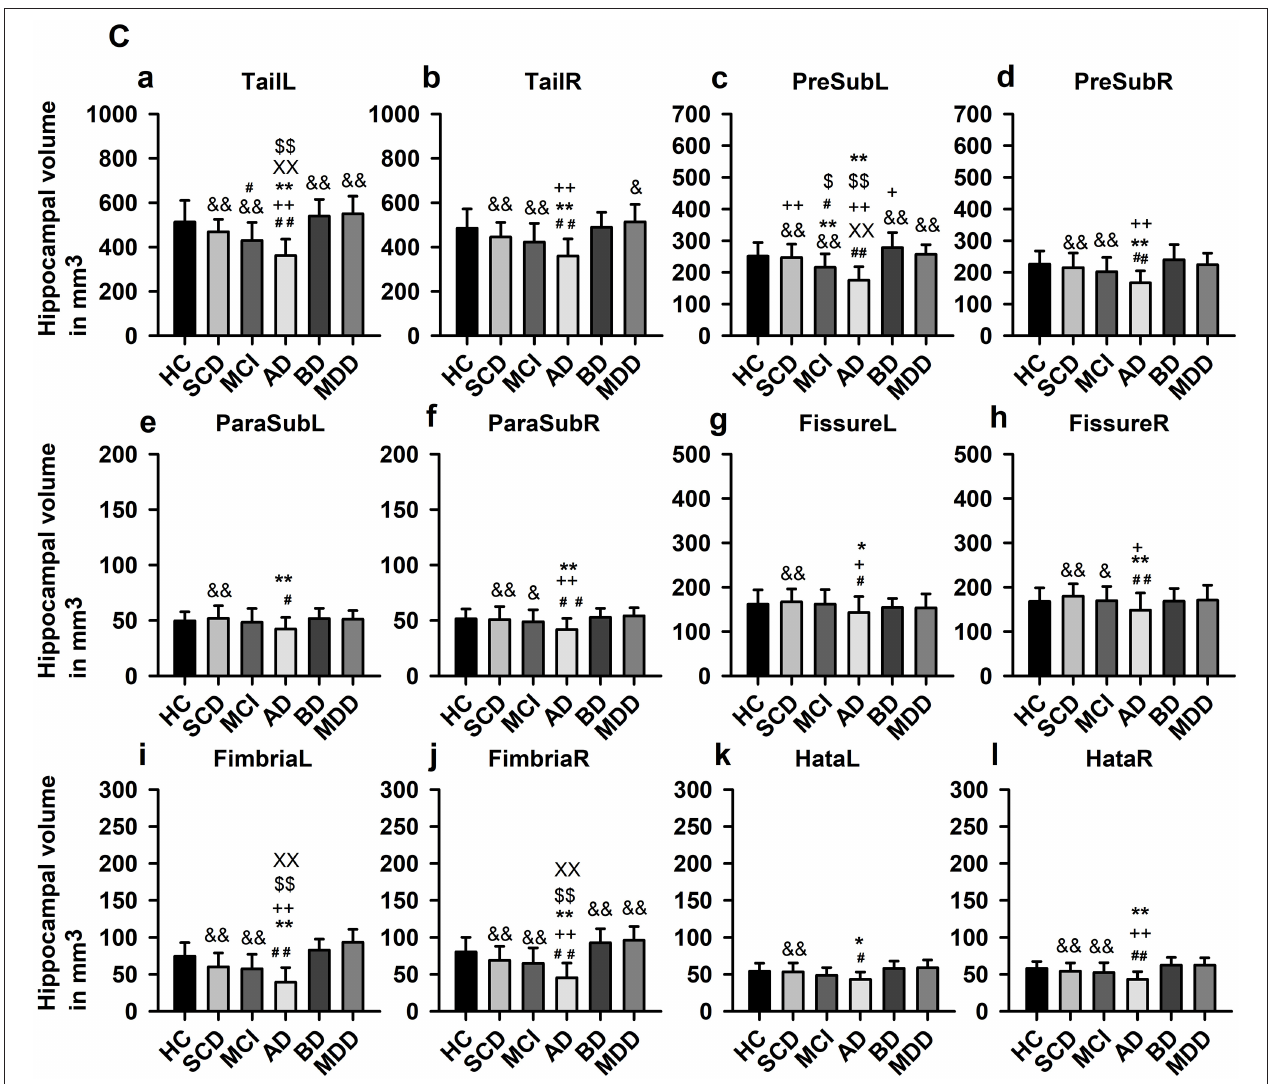
FIGURE 2 | Hippocampal subfield volumes across groups. (A) Whole hippocampus volumes compared in each hemisphere, (B) Hippocampal subfield (HippSub) volumes, including the CA1, CA3, CA4, DG, ML, and Sub as part of the hippocampus, compared in each hemisphere, and (C) Additional HippSub volumes including tail, PreSub, ParaSub, fissure, fimbria, Hata, compared in each hemisphere. Results refer to LSD post-hoc t -tests (two-sided) with Bonferroni correction between each condition. The significance level is indicated by different symbols: ## p < 0.005 vs. HC, ** p < 0.005 vs. SCD, ++ p < 0.005 vs. aMCI, & p < 0.005 vs. AD, $$ p < 0.005 vs. BD, xx p < 0.005 vs. MDD, * p < 0.05 vs. SCD, + p < 0.05 vs. aMCI, & p < 0.05 vs. AD, $ p < 0.05 vs. BD, x p < 0.05 vs. MDD. AD, Alzheimer’s disease; BD, bipolar disorder; CA1/3/4, cornu ammonis 1/3/4; HC, healthy controls; DG, granule cell layer-molecular layer of the dentate gyrus; Hata,